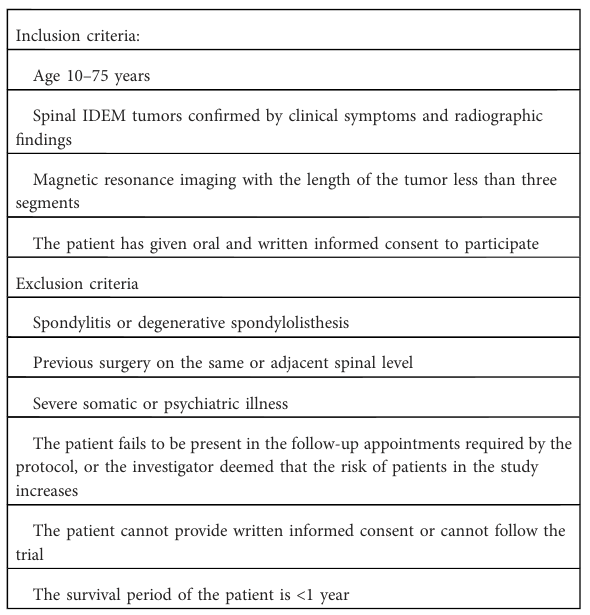
TABLE 1 Selection criteria for trial